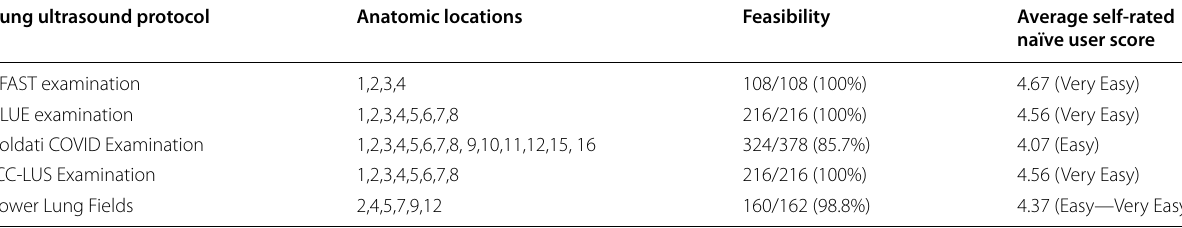
EFAST Extended Focused Assessment with Sonography for Trauma [23], BLUE Bedside Lung Ultrasound Assessment[44], Soldati COVID examination Proposal for International Standardization of the Use of Lung Ultrasound for Patients With COVID-19[22], ICC-LUS Examination International evidence-based recommendations for point-of-care lung ultrasound[26]. Mean Self-Reported Score was recorded as a 5-point Likert scale from 1 Hard to 5 Easy (1—Very Hard, 2—Hard, 3—Neutral, 4—Easy, 5—Very